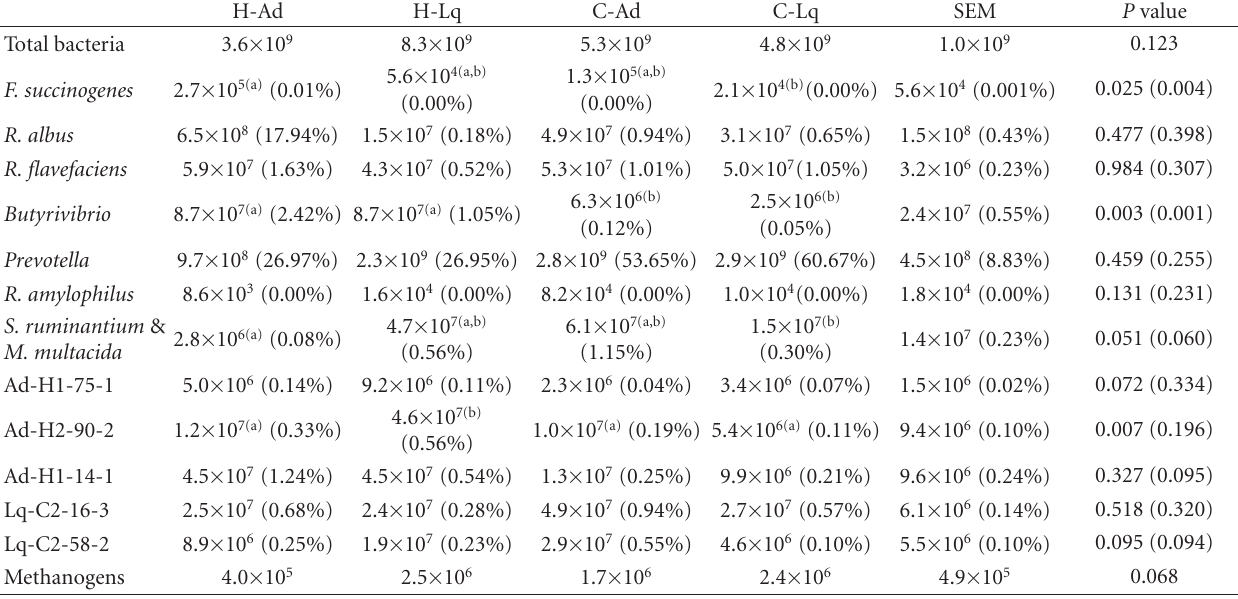
Table 3: Populations of bacteria (cultured and uncultured) and